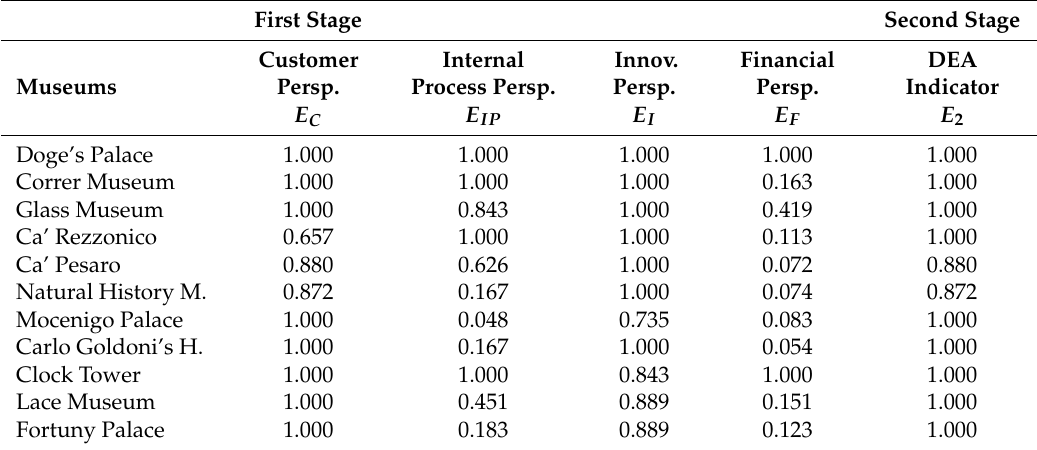
Table 6. Results from the first and second stage of the DEA-BSC model (synthetic